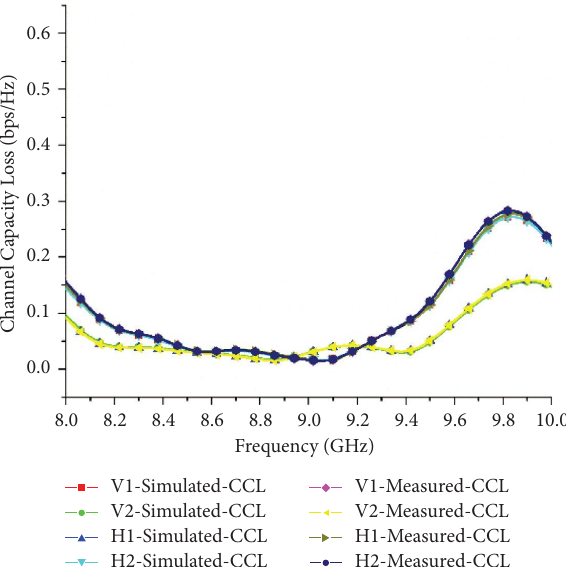
Figure 17: Freq vs.